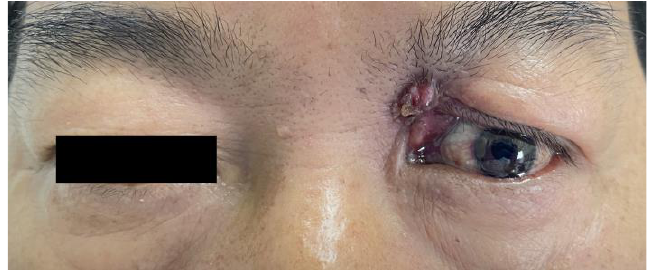
Figure 1. A scar contracture was seen on the medial side of the left upper eyelid.